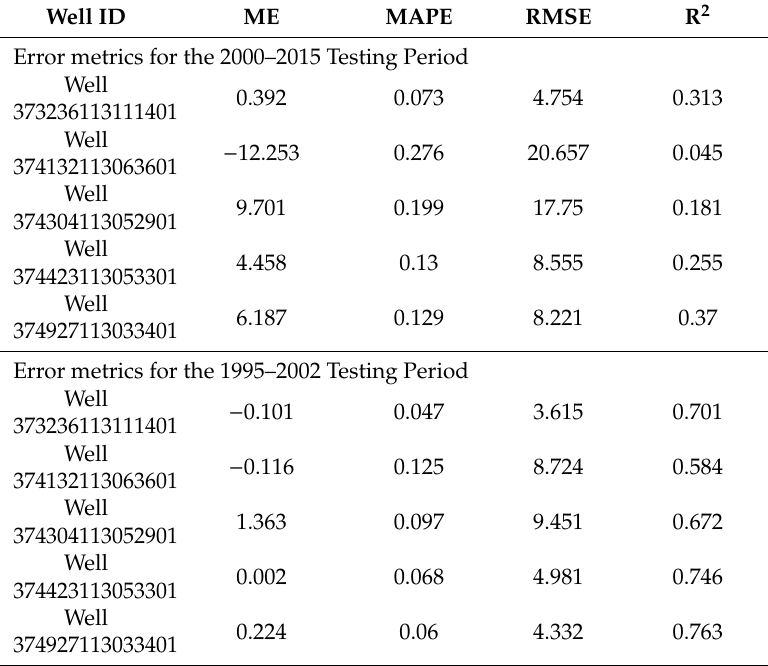
Table 1. ME, MAPE, RMSE and R 2 values for data imputed using the ELM model for Five Wells in Cedar Valley for both the 2000–2015 and 1995–2002 testing periods. Imputed data were compared to measured data in each period. Well ID ME MAPE